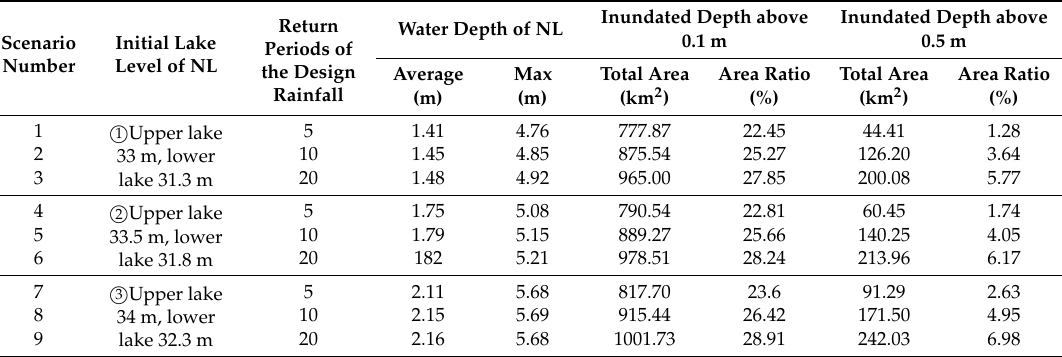
Table 4. Statistics of waterlogging. NL: Nansi